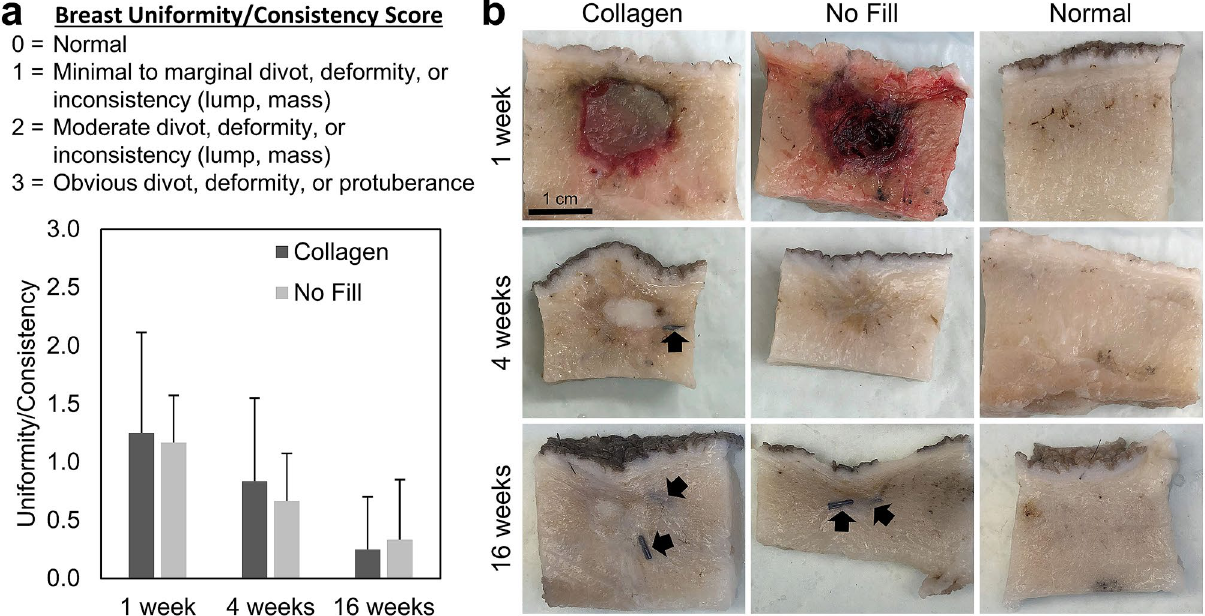
Figure 3. Collagen filler persists and induces site-appropriate tissue regeneration. ( a ) Graph showing breast uniformity/consistency scores (mean ± SD; collagen: n = 12; no fill: n = 6) assigned by breast surgeon for collagen and no fill (negative control) treated voids at various time points following simulated lumpectomy. All no surgery breasts scored 0. ( b ) Cross-sections of surgical voids following treatment with collagen or no fill compared to normal breast tissue. Arrows represent surgical clips placed to mark boundaries of surgical